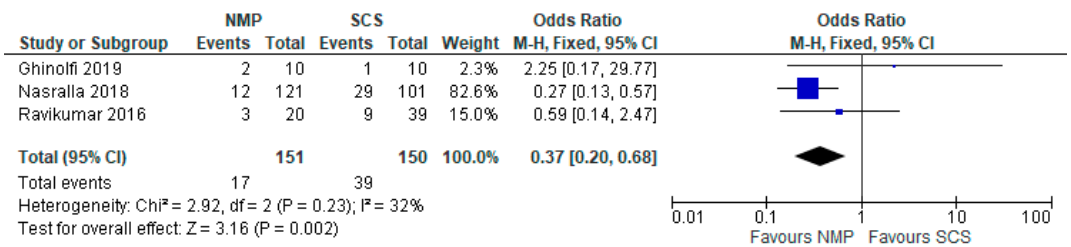
Figure 13. Early allograft dysfunction in livers preserved via HMP and SCS.